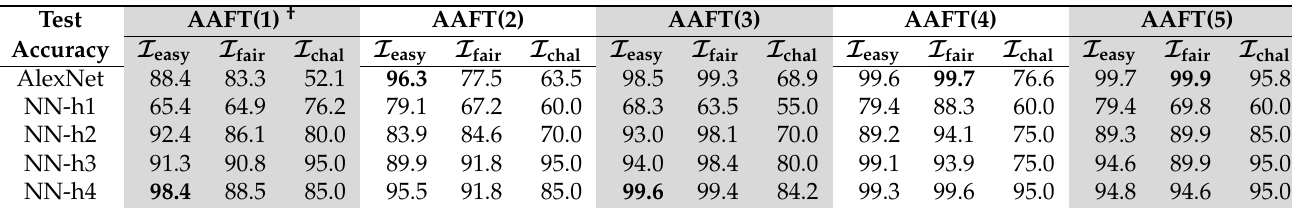
Table 5. The mean of test accuracy for AlexNet and NNs (%). h1 through h4 represent the number of hidden nodes in a hidden layer. Accuracy